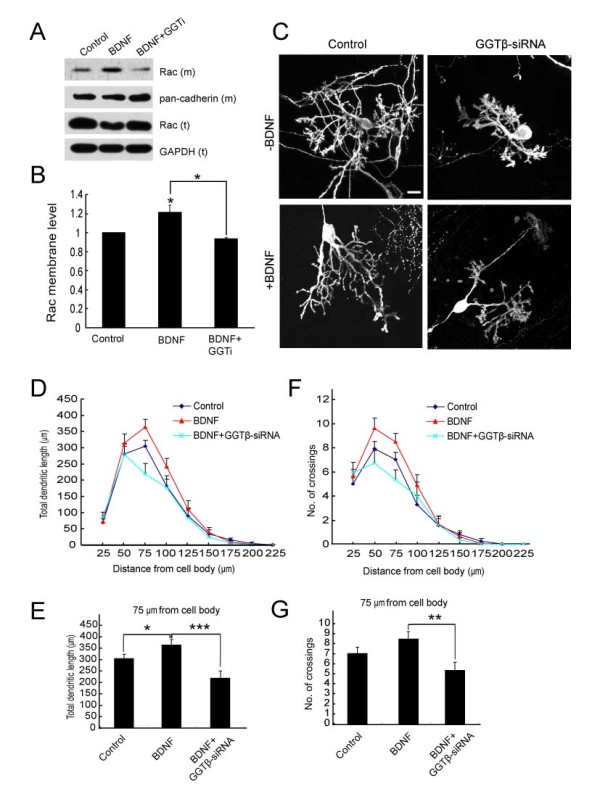
Effect of GGT-siRNA on BDNF-induced Purkinje cell dendrite development. A) Rat cerebellar slices at DIV2 were pre-treated with GGTi-2147 (2.5 μM) or vehicle (DMSO) for 45 min, followed by the treatment with BDNF (50 ng/ml) for 2 hr. Membrane fractions were separated and subjected to IB with antibodies against Rac and pan-cadherin. Total Rac or GAPDH was probed as loading controls. B) Quantification for the levels of membrane Rac, Rac (m). Data were shown as means ± SEM from three independent experiments. *P < 0.05. Student's t test. C) Representative images of Purkinje cells after transfection with pSUPER or pSUPER-GGTβ-siRNA, without or with 50 ng/ml BDNF treatments. D) Quantification for total dendritic length between neighboring circles. E) Quantification for total dendritic length between the circle of 50 and 75 μm. F) Quantification for the number of crossings at indicated distances from soma. G) Number of crossings at the circle with radius of 75 μm was quantitatively analyzed. Data are shown as means ± SEM (n = 33 for control; n = 44 for GGT-siRNA; n = 23 for BDNF; n = 21 for BDNF with GGT-siRNA). N.S. P > 0.05; *P < 0.05; **P < 0.01; ***P < 0.001. Student's t test. Scale bar = 20 μm.